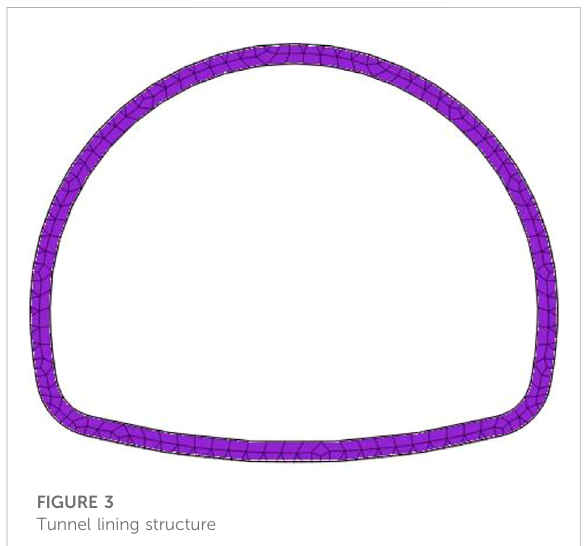
FIGURE 3 Tunnel lining structure